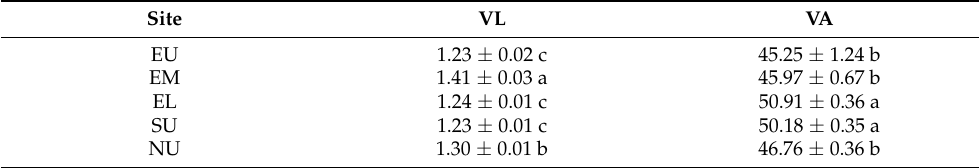
Table 4. Length and angle of extracellular enzyme vectors in different subsurface